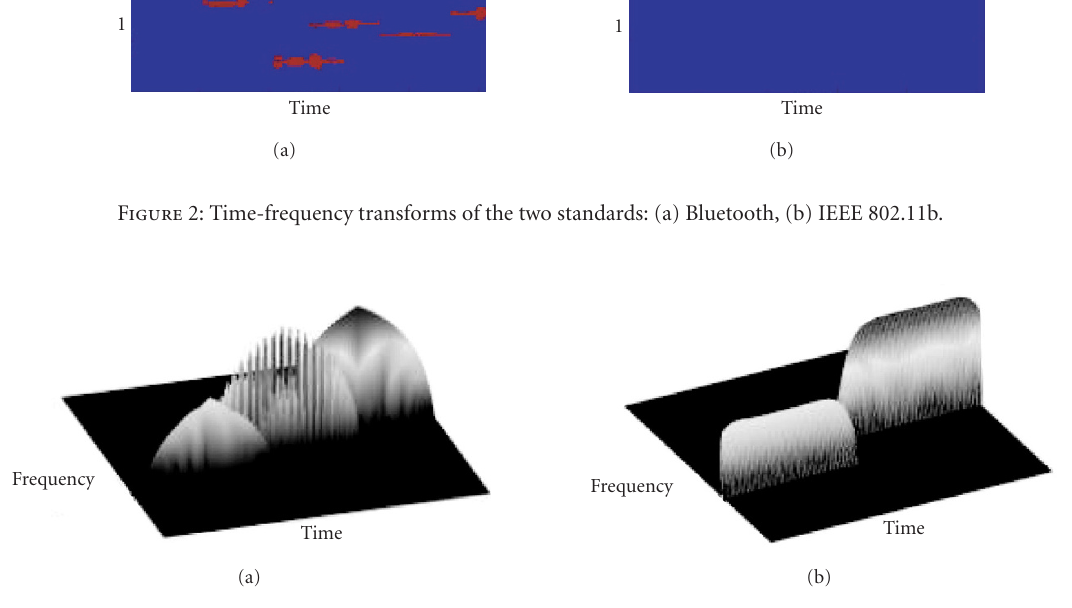
Figure 3: (a) Wigner distribution and (b) Choi-Williams distribution of an FH